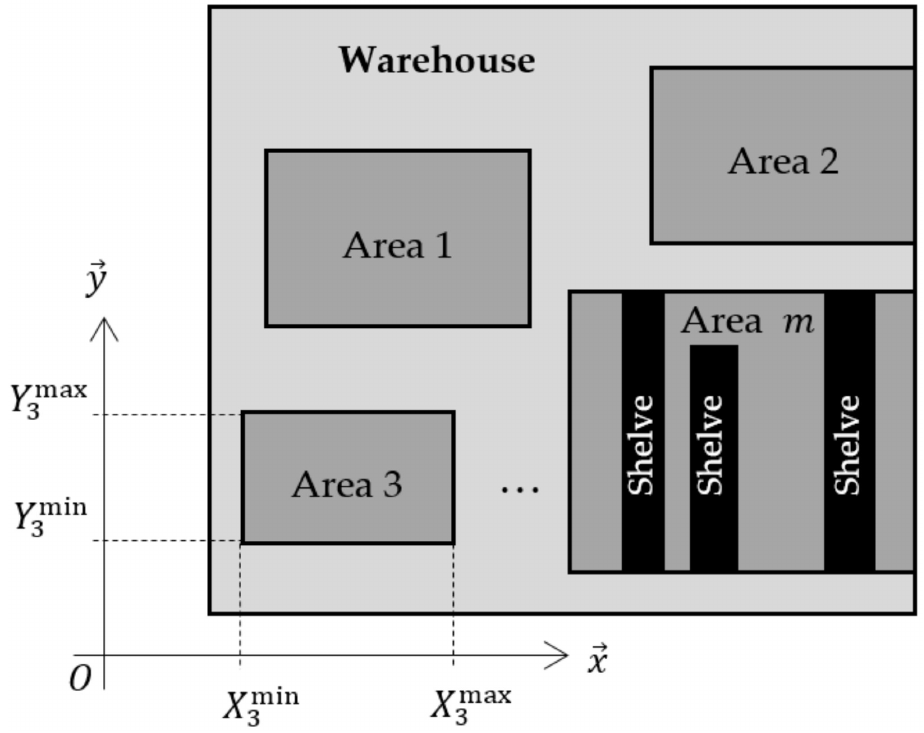
Figure 2. Varying organization of the warehouse, with m storage areas. An example of shelves’ organization is drawn for area m